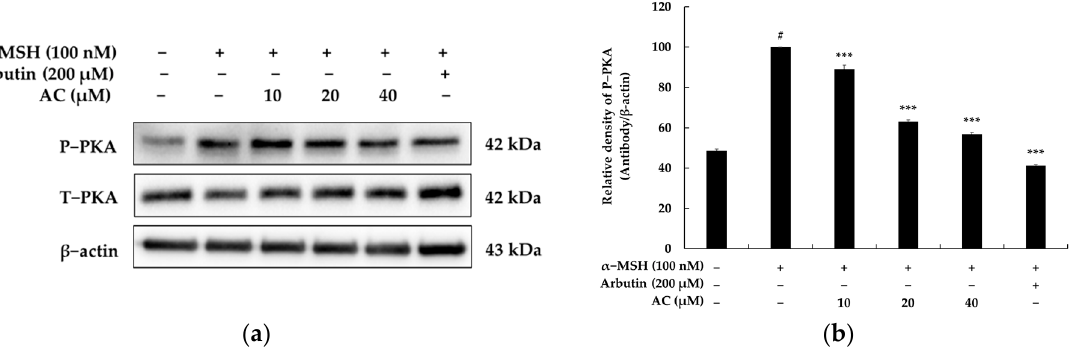
Figure 4. The e ff ect of acenocoumarol on PKA protein expression in α− MSH-stimulated Figure 4. The effect of acenocoumarol on PKA protein expression in α -MSH-stimulated B16F10 B16F10 cells. The cells were treated with acenocoumarol (10, 20 and 40 μ M) for 24 h in the cells. The cells were treated with acenocoumarol (10, 20 and 40 µ M) for 24 h in the presence of α -MSH (100 nM). ( a ) Western blotting results, ( b ) P-PKA protein expression. α -MSH was used as the negative control and arbutin (200 µ M) was used as the positive control. We conducted three repeated measurements using Image J and present the results as mean ± SD. Statistical significance was expressed as follows: # p < 0.001 vs. unstimulated control group, *** p < 0.001 vs. α -MSH alone.